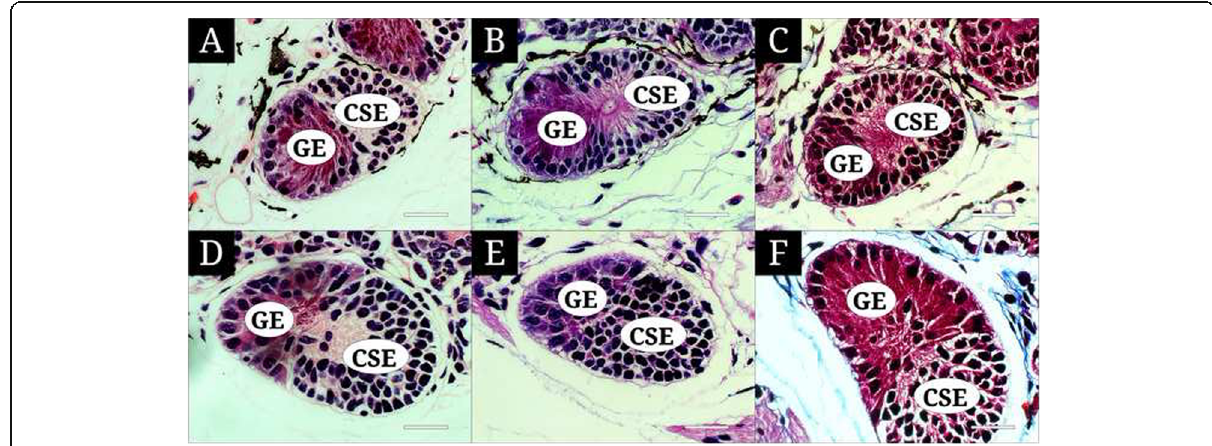
Fig. 3 The vomero-like epithelial crypt of Protopterus amphibius and P. dolloi , stained with hematoxylin and eosin ( a, d ), alcian blue (pH 2.5)- periodic acid Schiff ( b, e ), and Masson ’ s trichrome ( c, f ). a, b, c indicate P. amphibius and d, e, f indicate P. dolloi . CSE sensory epithelium; GE, glandular epithelium. The bars indicate 50 μ